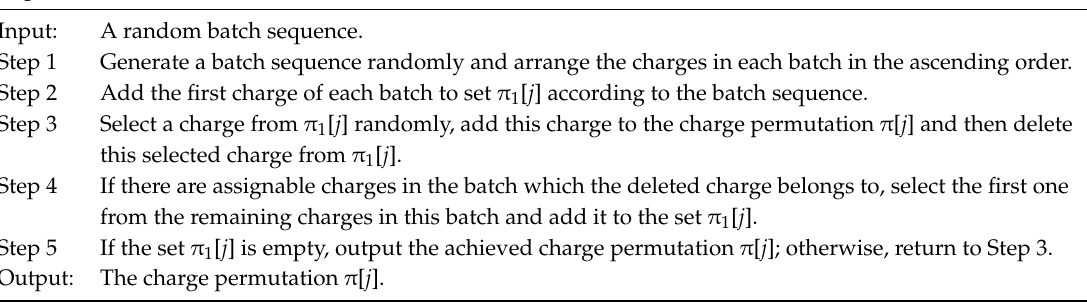
Algorithm 4 Procedure of the heuristic initialization